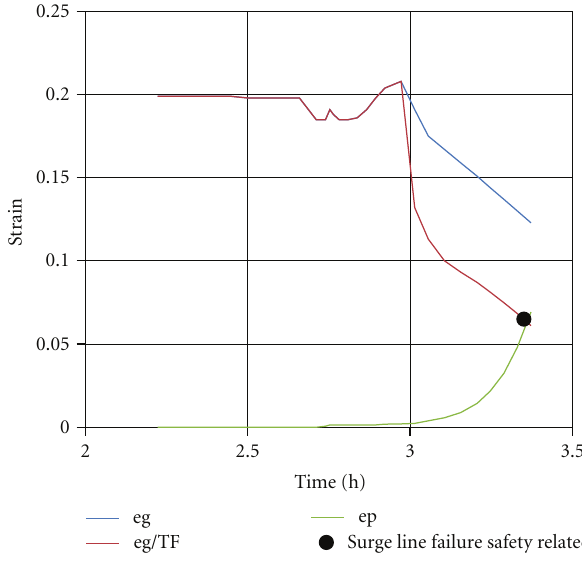
Figure 17: Structure mechanic assessment for a typical integration point in the MCL (eg: strain at uniform elongation concerning the respective temperature, eg/TF: strain at uniform elongation divided by stress triaxiality factor, ep: accumulated plastic strain).